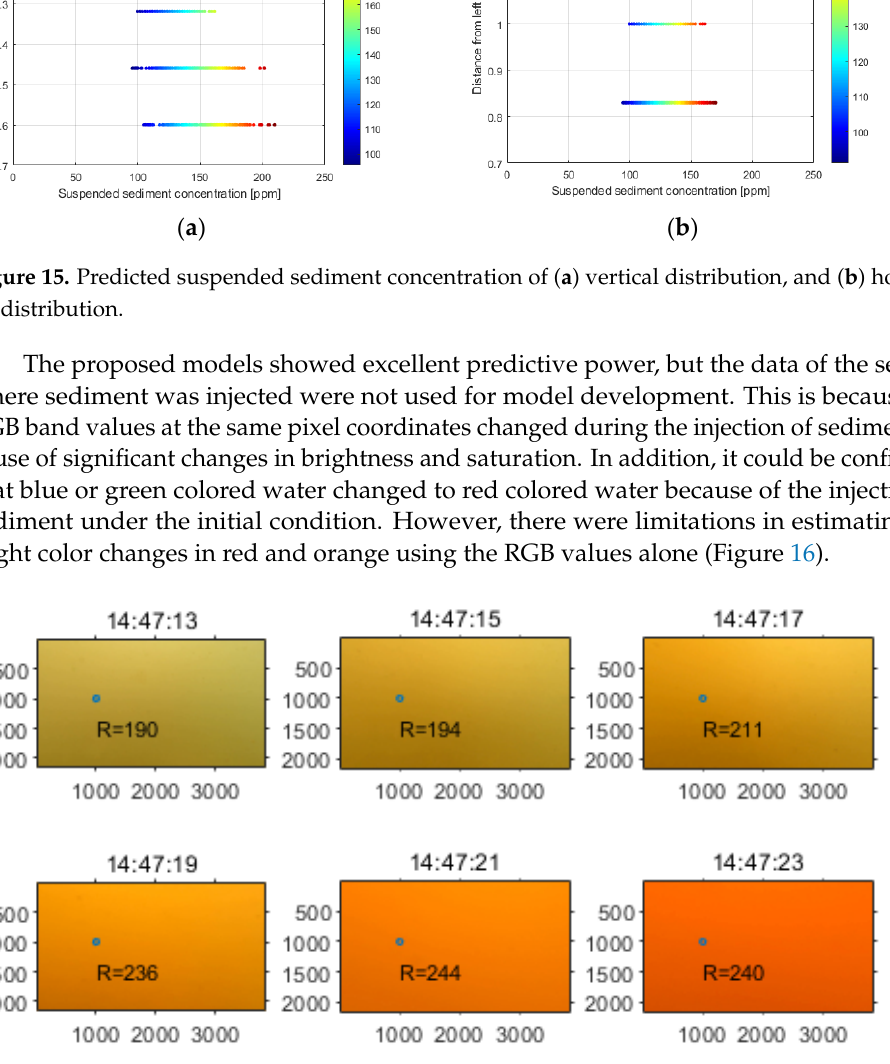
Figure 16. R value change at the (1000, 1000) pixel during the injection of the sediment mixture.